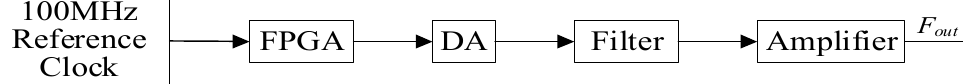
Figure 6. Modules of DDS frequency synthesizer based on FPGA. ( a ) Standard frequency source rubidium atomic clock PRS10; ( b ) FPGA implementation platform of DDS.